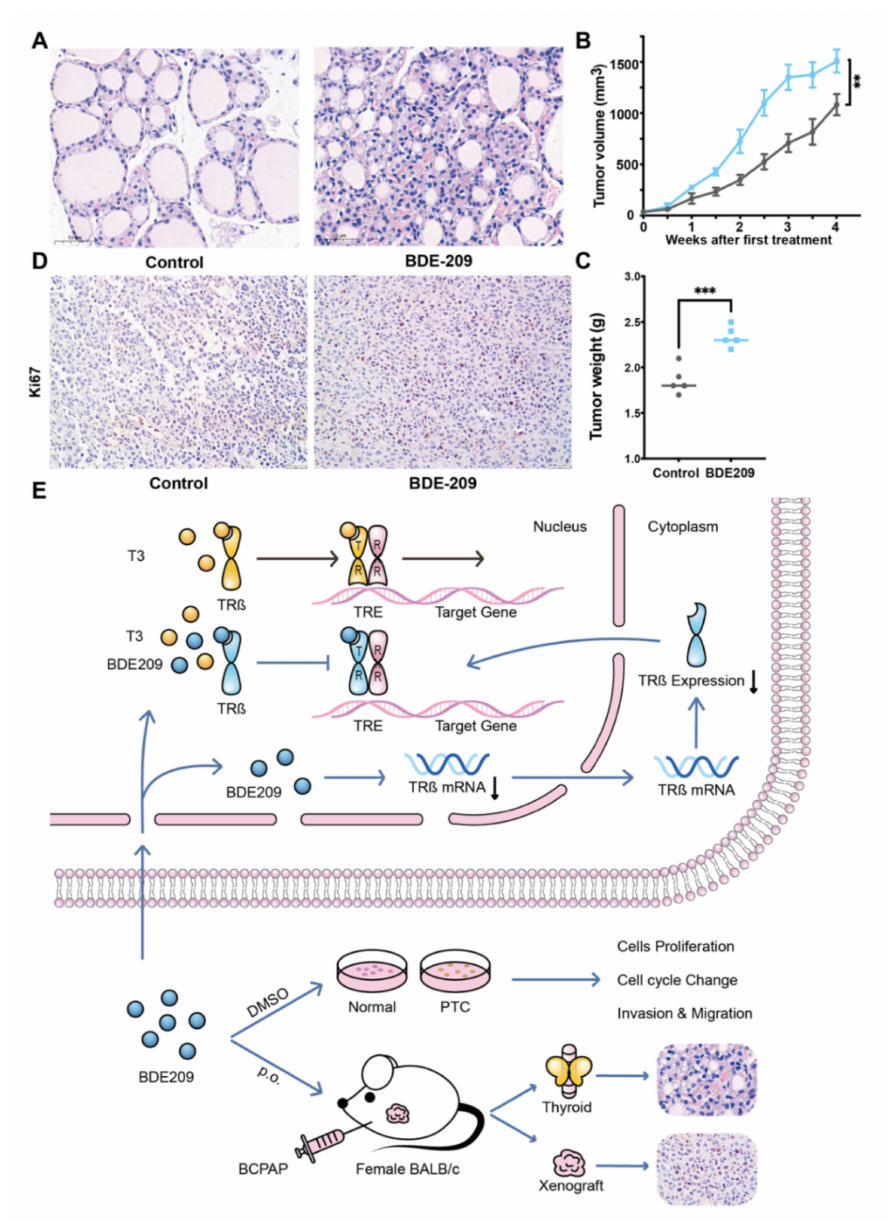
Figure 6. BDE209 promotes the proliferation of thyroid follicular cells and BCPAP cells in BALB/c female mouse xenograft models. ( A ) Mice bearing BCPAP xenografts were treated with control (peanut oil p.o.) or high dose BDE209 (2000 µ g/(kg/d) p.o.) for 4 weeks ( n = 5/group). Proliferative thyroid follicles with an increased number of follicular cells were observed in the BDE209 group compared with the control group. Scale bars, 50 µ m. ( B ) Tumour volumes with or without BDE209 exposure were measured twice per week. ( C ) Tumours were collected and weighed when the mice were sacrificed. ( D ) Immunohistochemical staining of the tumours with or without BDE209 exposure is shown. Scale bars, 50 µ m. ( E ) Working model of long-term exposure to decabromodiphenyl ether promotes the proliferation and tumourigenesis of papillary thyroid carcinoma by inhibiting